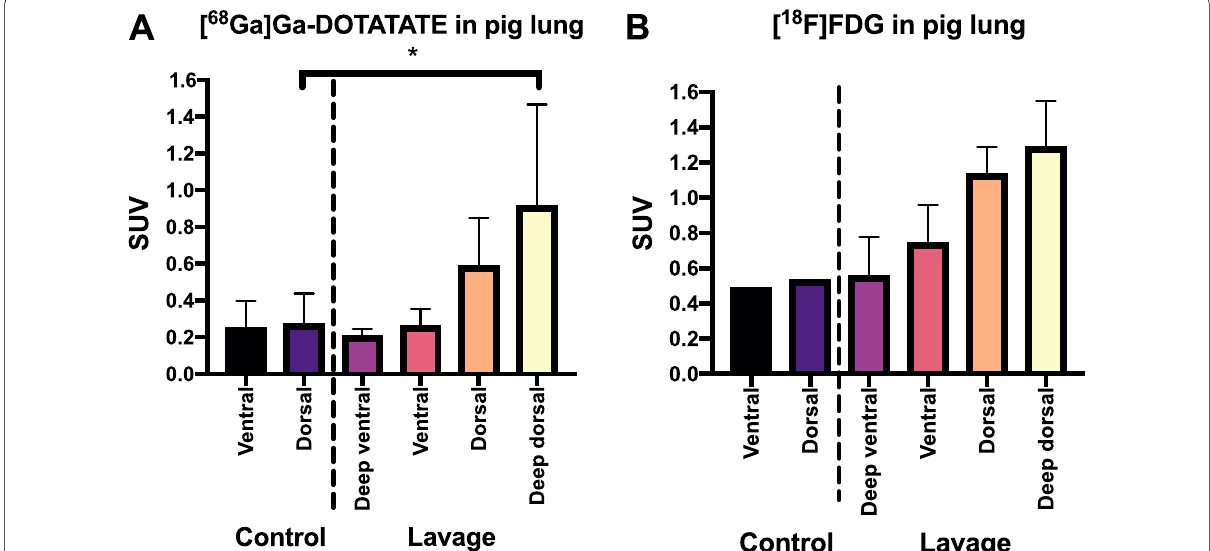
Fig. 4 Comparison of the PET uptake of ( A ) [ 68 Ga]Ga‑DOTA‑TATE and ( B ) [ 18 F]FDG in healthy control and pigs with lung inflammation at 60 min p.i. The [ 68 Ga]Ga‑DOTA‑TATE uptake was significantly increased on the deep dorsal parts of the lungs on the pigs induced with lavage, compared with the control animals. The uptake of [ 18 F]FDG is elevated on the control and sick animals in comparison with the [ 68 Ga]Ga‑DOTA‑TATE uptake. With both tracers, the SUV increased toward the deep dorsal parts of the animals with ARDS. The uptake on control animals remained on the same level on ventral and dorsal